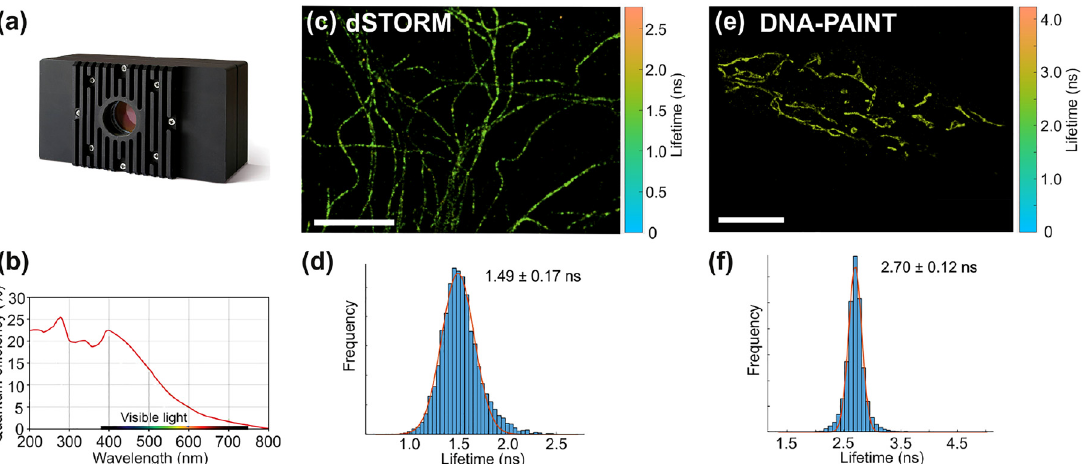
Figure 11: Fluorescence-lifetime SMLM using a wide-field imaging setup. (a) Commercially available TCSPC camera LINCam (Photonscore). (b) Quantum yield of the LINCam camera. (c) dSTORM FL-SMLM image of microtubules in hMSC labeled with Alexa 647. Scale bar is 5 μ m. (d) Lifetime histogram extracted from individual single-molecule localizations in image (b). (e). DNA-PAINT FL-SMLM of mitochondria in HeLa cells labeled with Cy3b. Scale bar is 10 μ m. Lifetime scale bars are shown on the right of images (c) and (e). (f). Lifetime histogram extracted from single-molecule localizations in image (e). Data was fitted with single Gaussian distributions. Average lifetime and standard deviation values are shown. The images in (a) and (b) are reprinted with permission of Photonscore